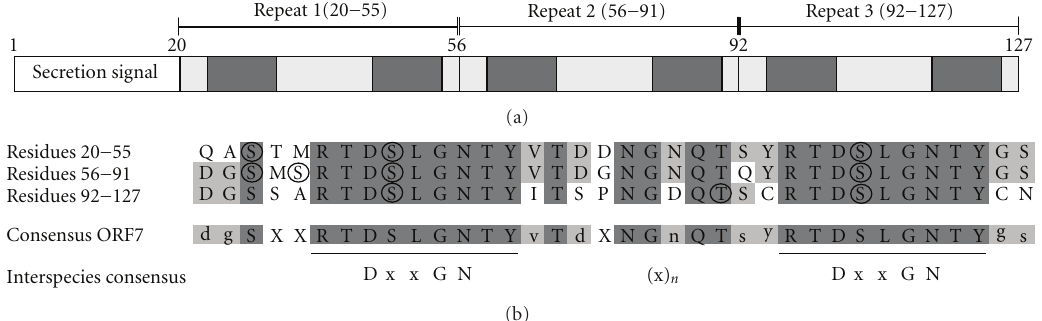
Figure 3: ORF7 of plasmid pYe4449-2 encodes a putative new repeat protein with a high content of phosphorylatable amino acids. (a) Scheme of the arrangement of the ORF7-encoded hypothetical protein. The nonameric repeat module “RTDSLGNTY” occurring twice in each repeat is indicated by dark grey boxes. (b) Alignment of the protein repeat segments encoded by ORF7, residues identical in all three repeats are highlighted against a dark grey background and residues identical in two of the three repeats are highlighted against a light grey background. The repeat module “RTDSLGNTY” occurring twice in each repeat is indicated by a bar below the consensus sequence. Below these bars, DxxGN” is given as deduced from the closest homologues of ORF 7 (BACOVA 04330; NE2449; the interspecies repeat motif “DxxGN(x) n MPG2080 02246). Serine and threonine residues most likely to be phosphorylated in a eukaryotic background according to NetPhos 2.0, server predictions (score 0.968 and above) were indicated by circles.